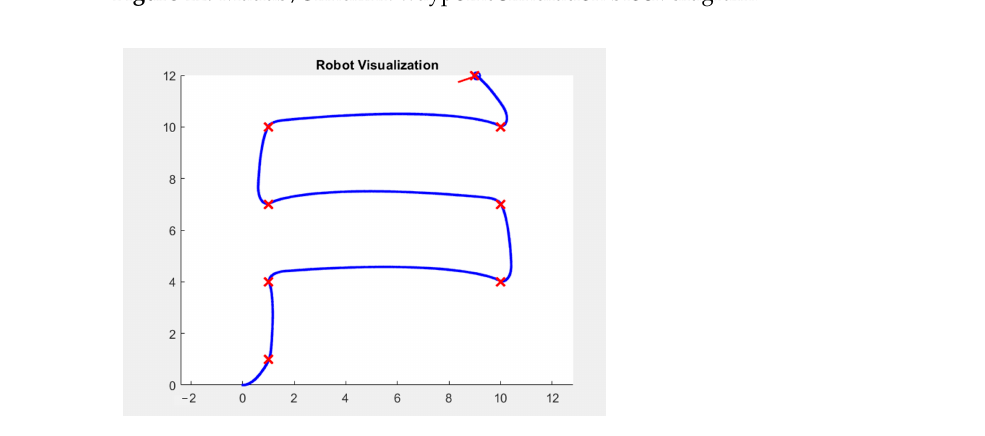
Figure 12. Matlab/Simulink waypoint simulation block diagram.